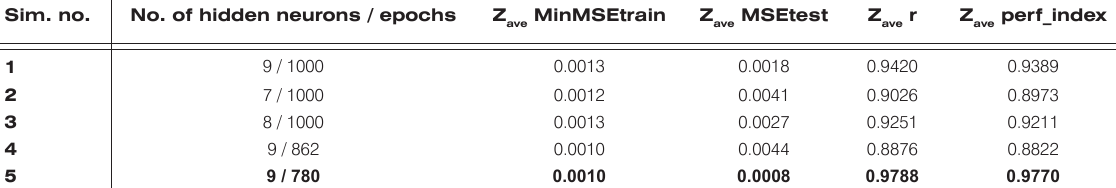
Table 3. The results of the simulations for optimizing the number of hidden neurons for the neural network modelling the average diameter. Sim. no.